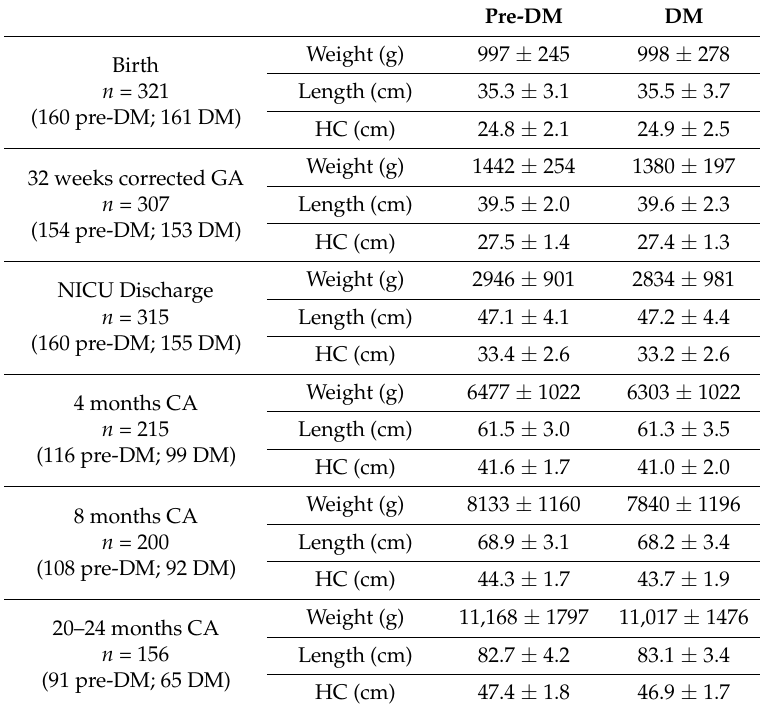
Table 2. Longitudinal anthropometrics for